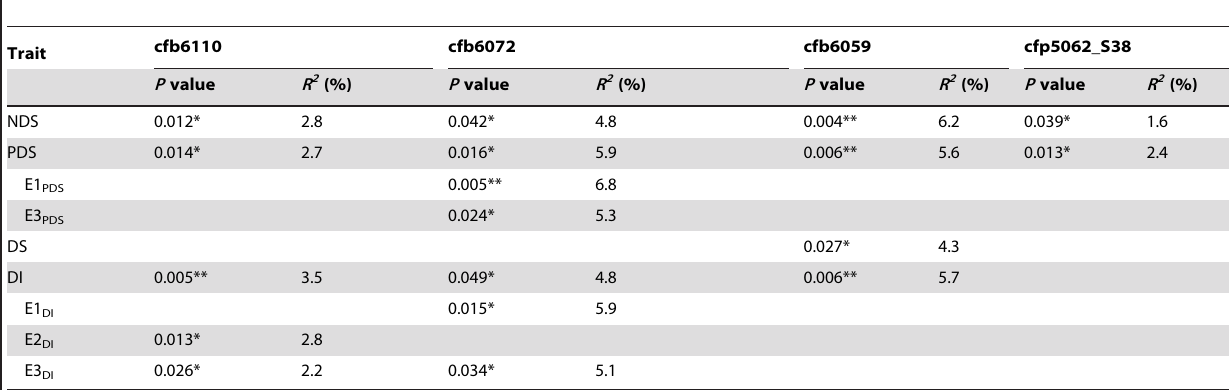
Table 4. Significance ( P value) and genetic variation ( R 2 ) explained by individual markers associated with FHB-related traits.